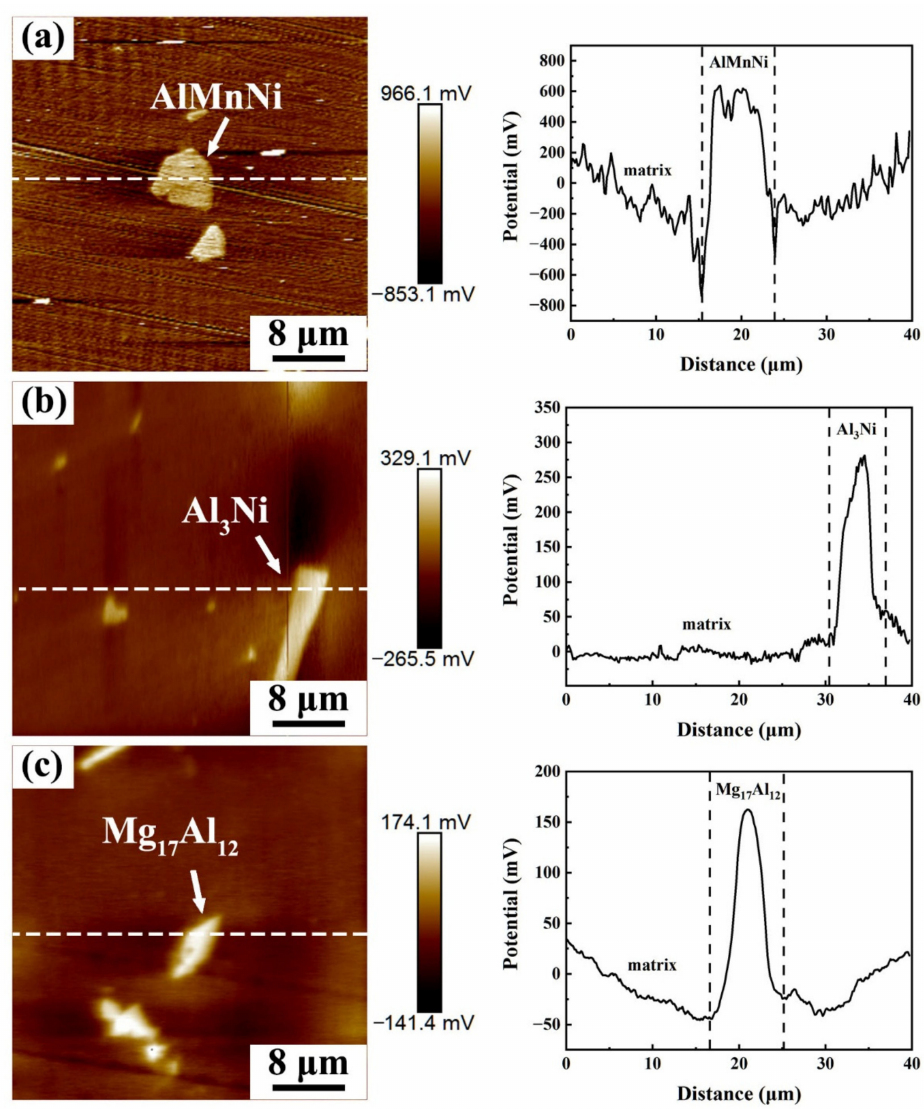
Figure 9. The Volta potential of the precipitate phases in the AZN800-B alloy: ( a ) The Volta potential of AlMnNi phase; ( b ) The Volta potential of Al 3 Ni phase; ( c ) The Volta potential of Mg 17 Al 12 phase. The surface micrographs of the AZN800-B alloy immersed in 3 wt.% KCl at 25 ◦ C